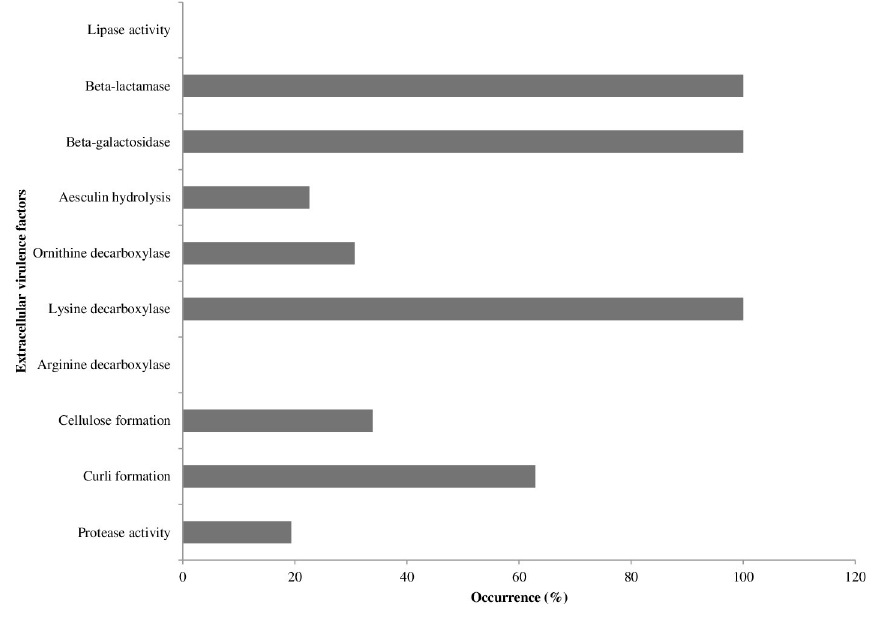
Fig 1. Extracellular virulence factor formation of the E . coli isolates.